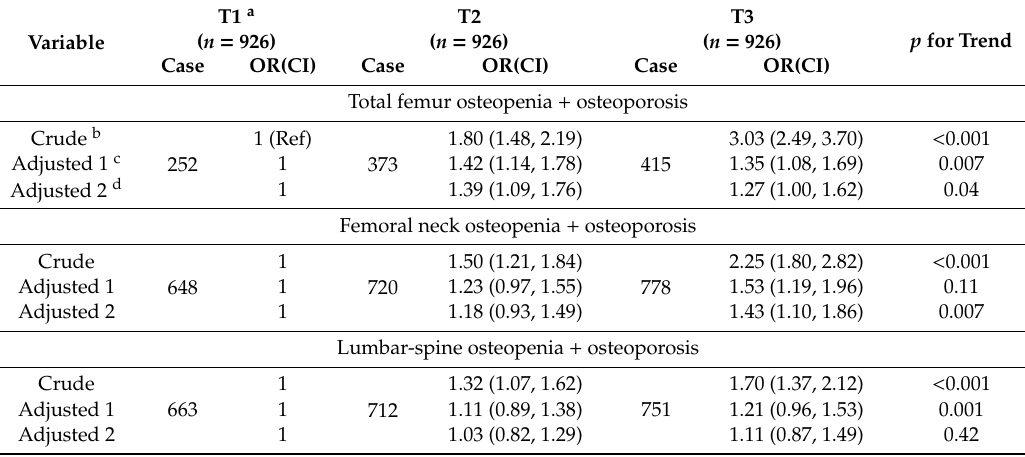
Table 3. Multivariate adjusted odds ratios (OR, 95% confidence intervals) for osteopenia + osteoporosis by tertiles of DII ®